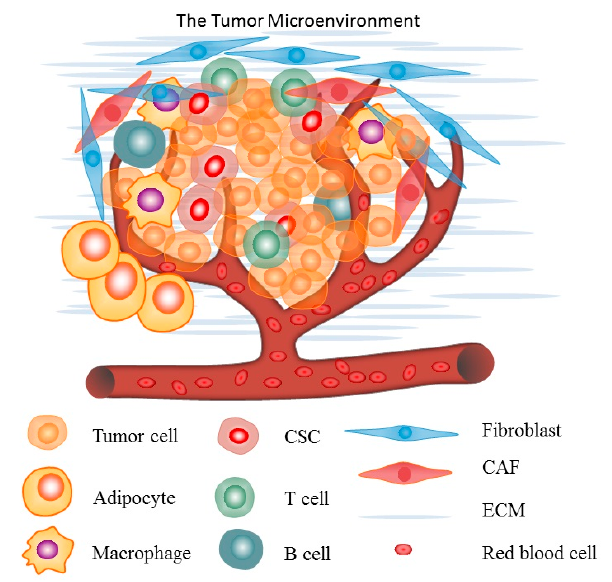
Figure 1. An illustration of the tumor microenvironment.